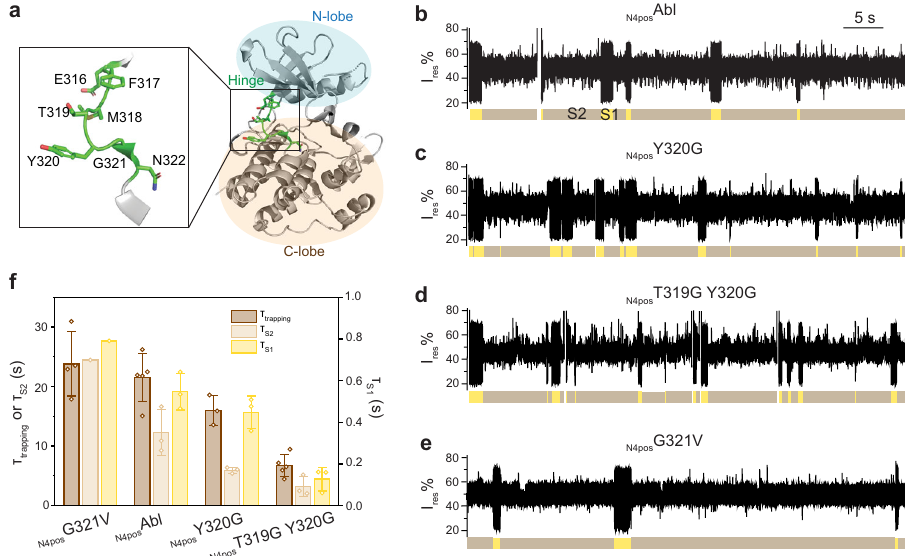
Fig. 3 Effect of Abl kinase hinge mutations on the S1/S2 state transitions. a Structure of Abl kinase domain (gray, PDB: 2HYY) with hinge region colored in green. N-lobe and C-lobe are indicated by the pale blue and beige circles respectively. A magni fi ed image shows the detailed hinge structure with side chain of hinge residues (316-322) shown as stick. b – e Representative current traces of apo N4pos Abl ( b ), N4pos Y320G ( c ), N4pos T319G Y320G ( d ) and N4pos G321V ( e ) trapped with ClyA-AS nanopore tweezers. Signal patterns S1 and S2 are highlighted in yellow and brown, respectively. All current traces were collected at − 80 mV in 150 mM NaCl, 100 mM Tris-HCl, pH 7.5, at 22 °C, with ~100 nM Abl kinase added to cis chamber. f Comparison of the dwell times of trapping and S1, S2 states of different Abl hinge mutants. Data were represented as mean ± SD, n = 5 independent replicates for τ trapping of n = 4 independent replicates for τ n = 3 independent replicates for τ n = 3 N4pos Abl and N4pos T319G Y320G, trapping of N4pos G321V, trapping of N4pos Y320G, independent replicates for τ S1 and τ S2 of N4pos Abl, N4pos Y320G and N4pos T319G Y320G. Of note all complete S1 or S2 from multiple experiments were combined to derive the τ S1 and τ S2 for N4pos G321V. Consequently, we were not able to derive standard deviation for τ S1 and τ S2 for N4pos G321V (see Methods for more details). Source data are provided as a Source Data fi